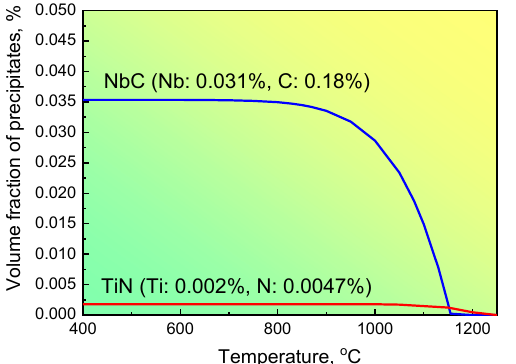
Figure 6. The precipitation of NbC changed with different temperatures for steel S1. For steel S2, 356 particles were achieved based on six images with a scanning area of 3.8 μ m × 3.6 μ m. The statistical results in Table 5 show that the particle size in steel S2 is in the range from 4.6 to 54.7 nm, and that the average size of the particles is approximately 25.4 nm. The distribution of the precipitate size in steel S2 is described in Figure 7. Ap- proximately 85% of the precipitates had a size less than 30 nm. The application of these values to Equation (1) shows that the volume fraction of precipitates in steel S2 is approx- imately 0.095% based on the experimental observations. Table 5. Statistical analyses of the size and composition of precipitates in steel S2. No